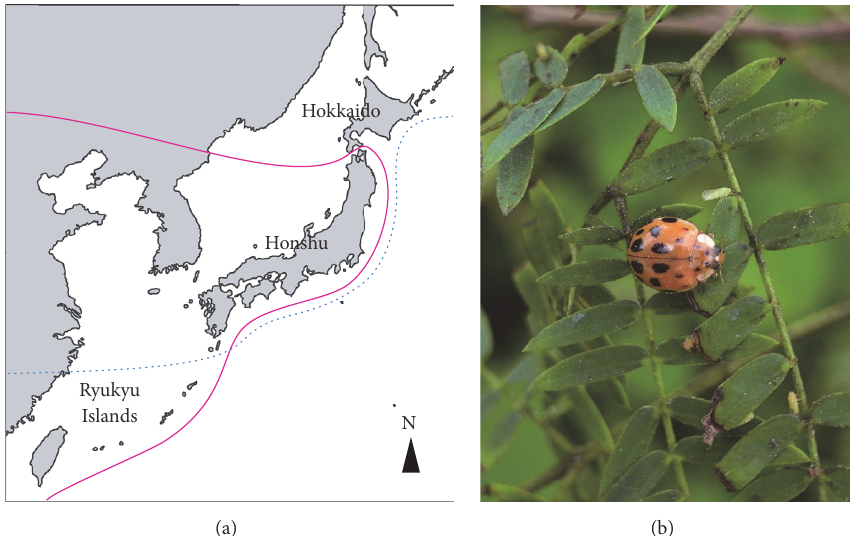
Figure 4: (a) Natural distribution of H. yedoensis (red solid line) and H. axyridis (blue dotted line) around the Japanese archipelago (modified from Sasaji [24]). The two species are sympatric in central Japan (Honshu), whereas only H. yedoensis is found in the Ryukyu Islands and only H. axyridis in Hokkaido. (b) Harmonia yedoensis on a lead tree, Leucaena leucocephala , on Miyako Island, southern Ryukyus. In areas where H. axyridis does not occur, H. yedoensis adopts a generalist